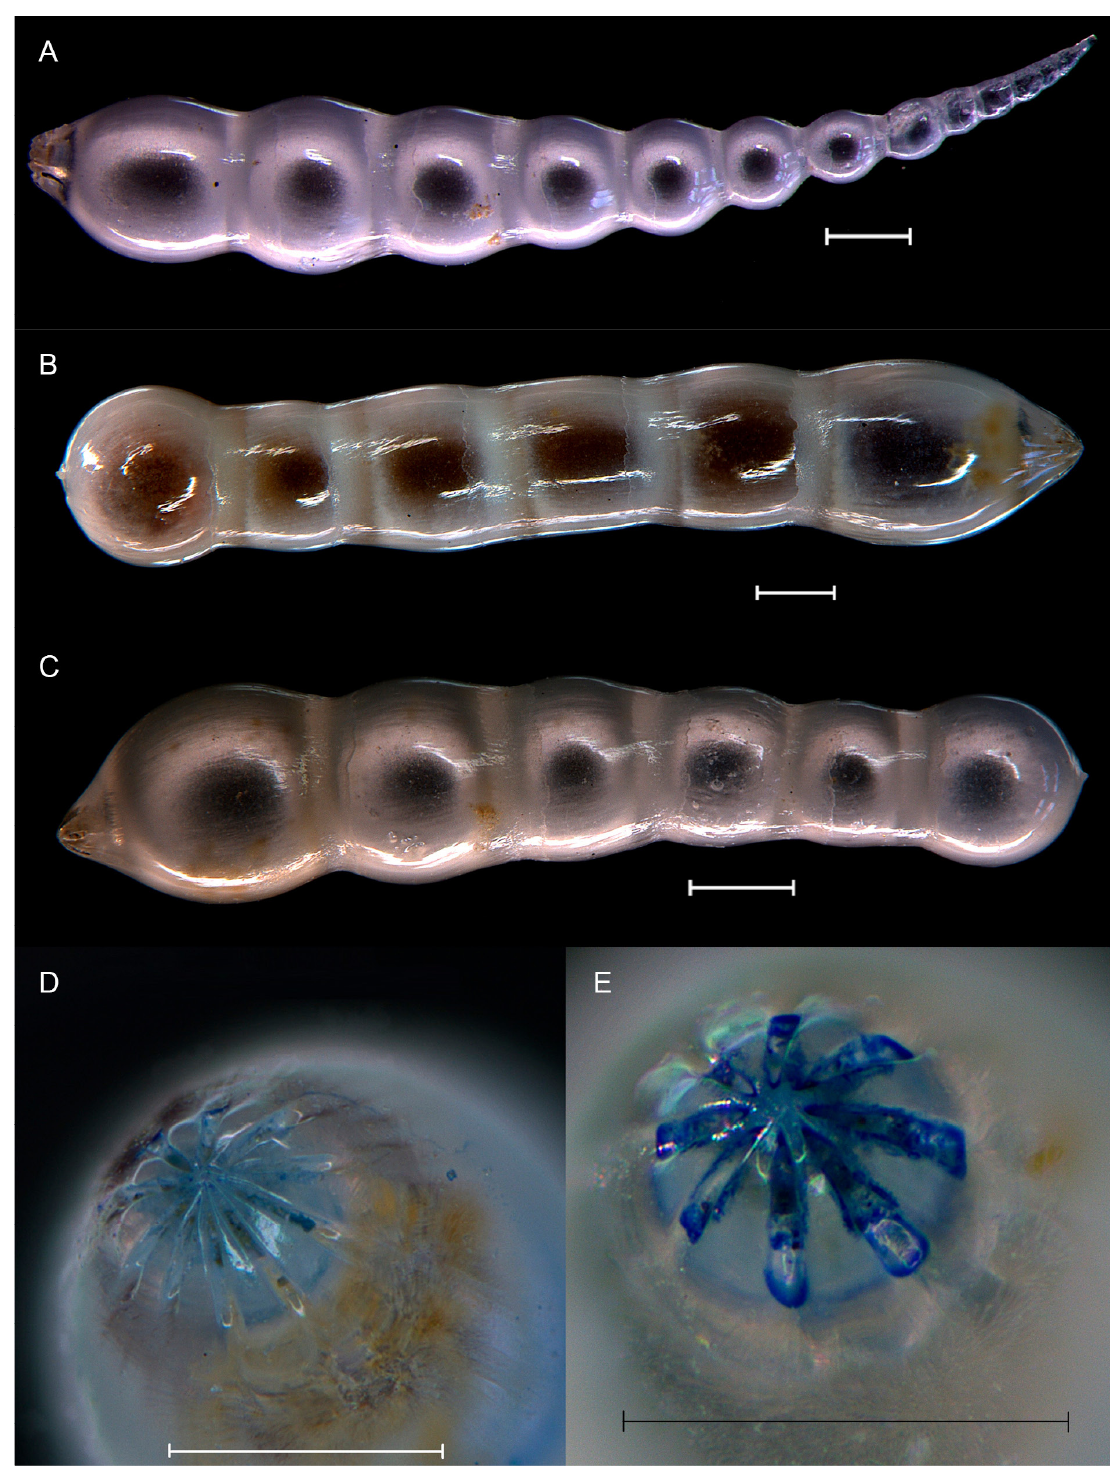
Fig. 13. Nodosaria haliensis Eiland & Gudmundsson, 2004. A . Microsphere side view (BIOICE 2526, IINH 40311). B, E . Megalosphere (BIOICE 2118, IINH 40276), side view (B) and aperture (E) stained with indigo blue. C, D . Megalosphere (holotype, BIOICE 2588, IINH 40319), side view (C) and aperture (D) stained with indigo blue. Light source combination of incident light and dark field. Scale bars = 0.25